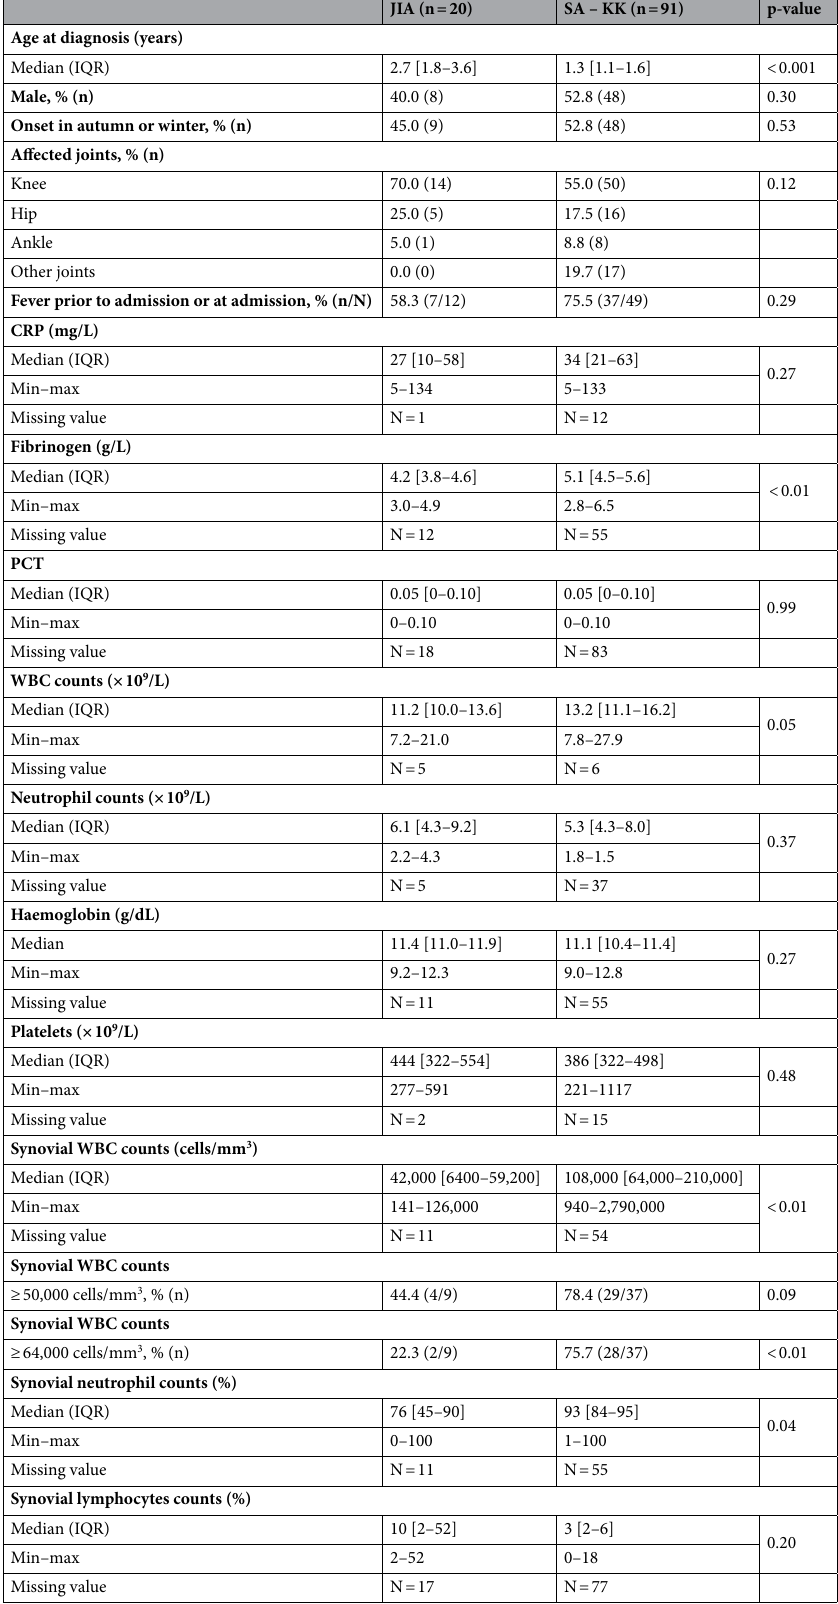
Table 5. Characteristics and care of children with juvenile idiopathic arthritis and septic arthritis due to Kingella kingae